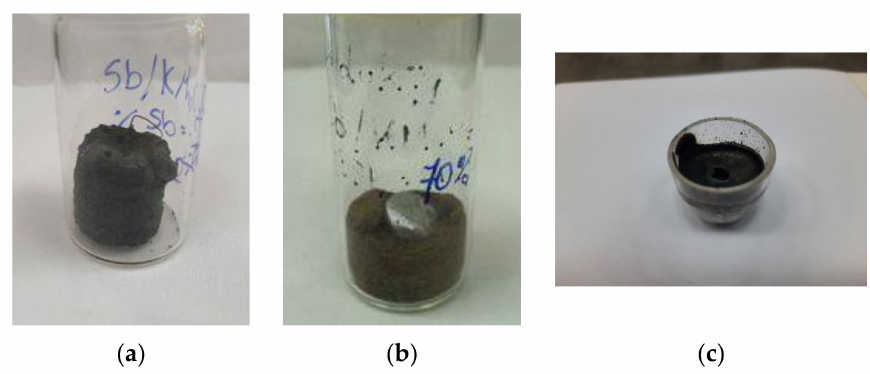
Figure 8. Solid products of combustion of Sb/KMnO 4 compositions: 35% Sb ( a ), 70% Sb ( b , c ). Table 1. Results of combustion of Sb/KMnO 4 compositions in the calorimetric bomb filled with argon at a pressure of 2 MPa (the mass of the metallic Sb in